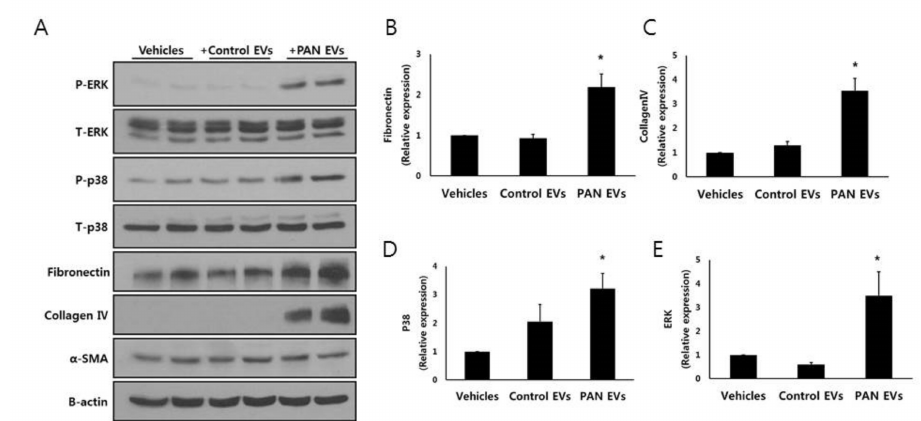
Figure 4. EVs from injured podocytes change HK2 cells. ( A – C ) Co-incubation with EVs from PAN-treated podocytes increased expression of apoptosis marker (cleaved poly (ADP-ribose) polymerase (PARP), fibronectin, and collagen IV) of HK2 cells. ( D , E ) EVs from PAN-treated podocytes activated the extracellular signal-regulated kinase (ERK) and p38 pathways in HK2 cells. * p < 0.05 vs.